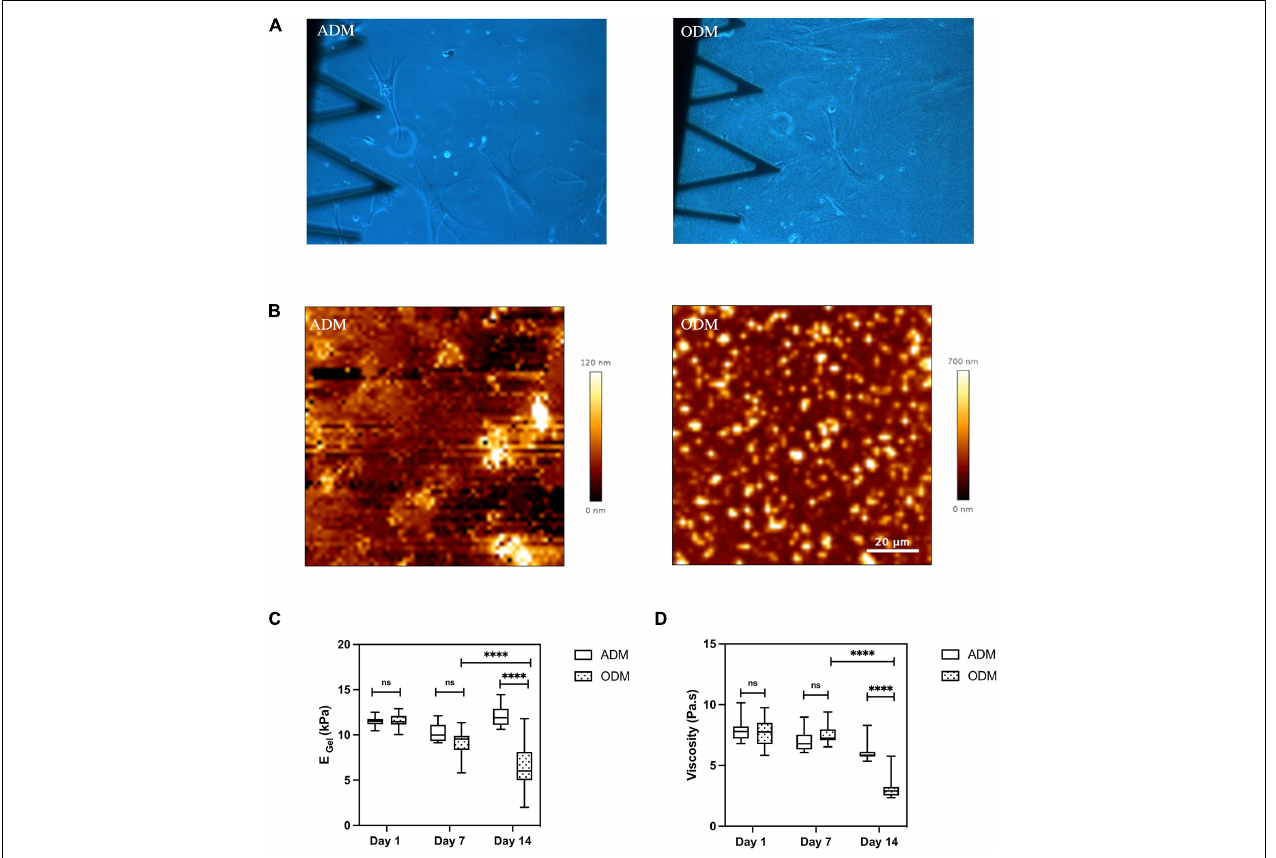
FIGURE 4 | Gelatin hydrogel remolded during MSCs differentiation. (A) Optical images (10 × magnification) of gelatin hydrogel at day 14. (B) Surface of gelatin substrates scanned by AFM at Day 14. Box plots show the results of the (C) Young’s modulus and (D) viscosity of gelatin hydrogel cultured with hMSCs in ADM/ODM at different time points. Box plots extend from the 10th to the 90th percentile, whiskers from min to max. Error bars represent SD for n = 6 replicates from three separate experiments. Asterisks indicate a statistical difference ( ∗∗∗∗ P < 0.0001, using a nested 1-way ANOVA design followed by a multiple comparisons Dunnett’s test against day 1). ns indicates not significant